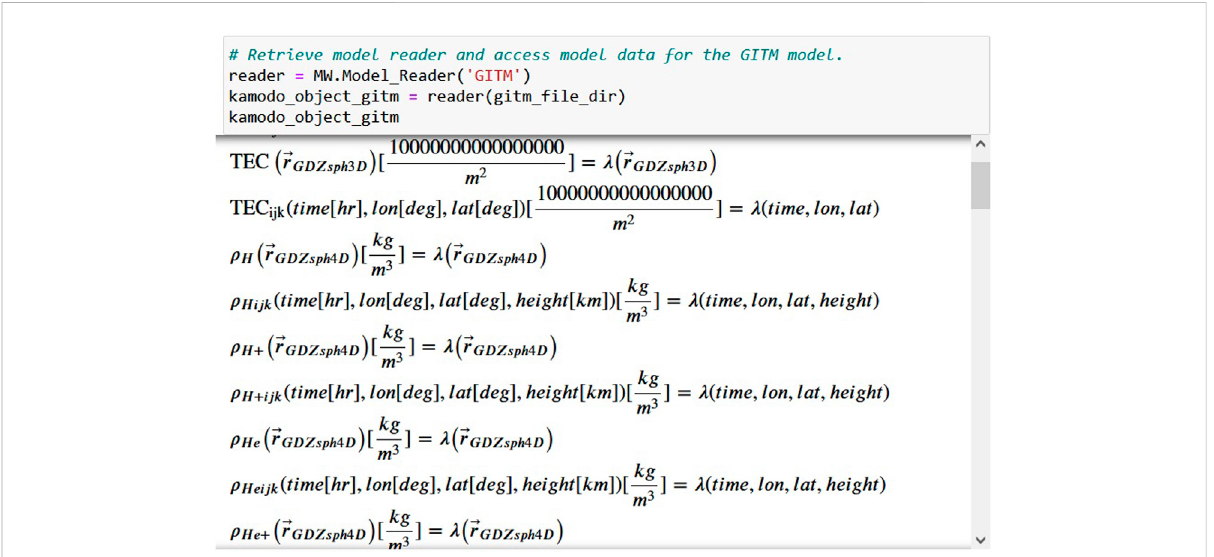
FIGURE 1 An example of a model reader interface in Kamodo. After an import statement, the user retrieves the model reader for the desired model with the fi rst command, and then functionalizes the data with the second command of the same block. The only user-supplied information needed is which model is desired and thelocation of the data. The output shows the functionalized data for the variables found in the fi les indicated. Once the data is functionalized, all of the capabilities of Kamodo are available through simple commands. See Pembroke et al., 2022 and Ringuette et al., 2022a for more